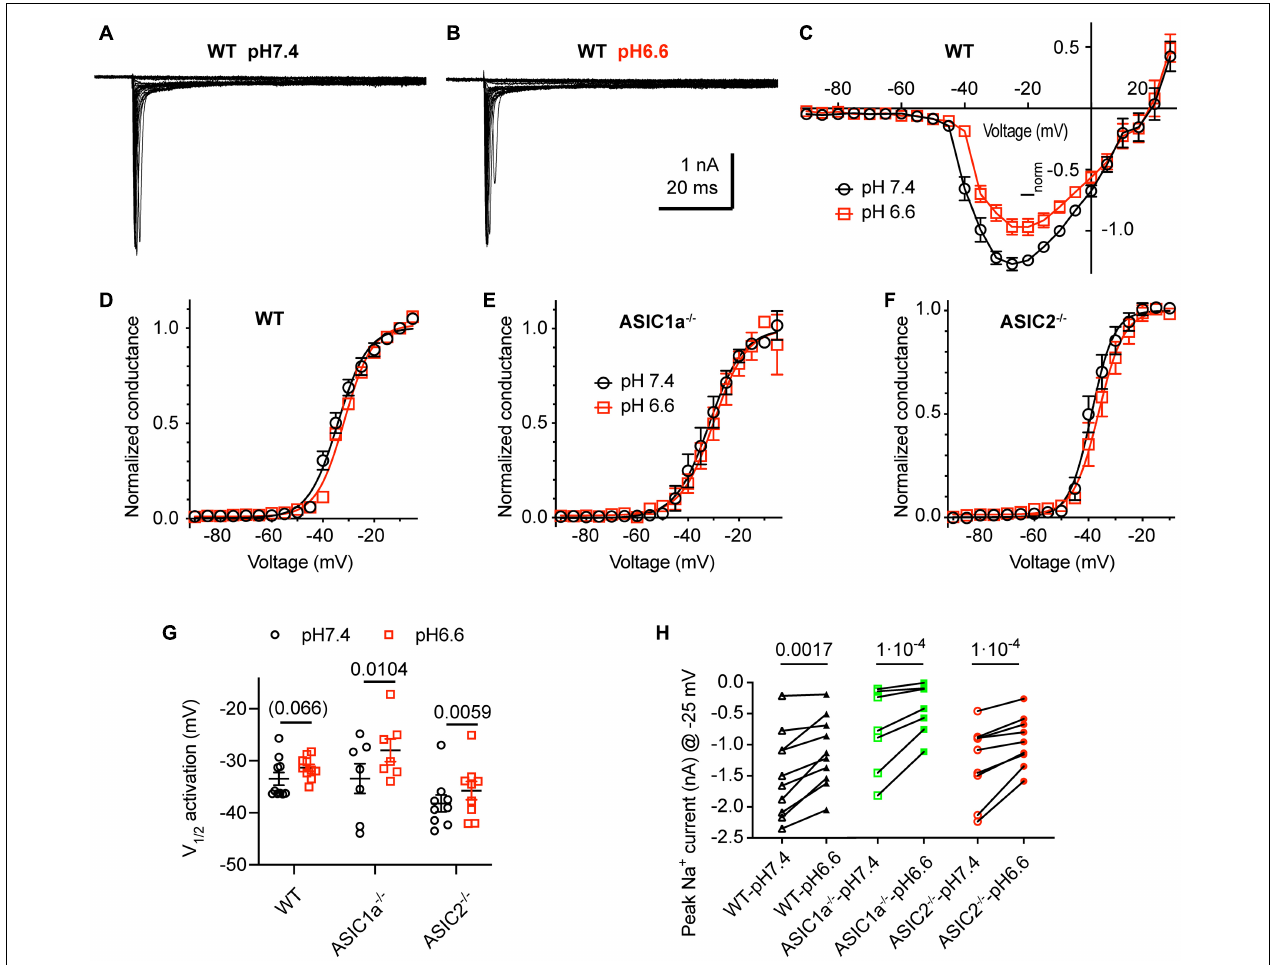
FIGURE 5 | Acidification to pH6.6 induces a small inhibition of voltage-gated Na + channels. Experiments were done in whole-cell voltage-clamp on cortical neurons. The voltage protocols are described under Materials and methods . The response to two different solutions was directly compared in the same cell. Only the pH was changed between the two conditions. (A,B) Representative current traces obtained at pH7.4 (A) and pH6.6 (B) from the same WT neuron (C) Na V I-V curve at pH 7.4 and 6.6. Current amplitudes were normalized in each cell to the amplitude measured at pH7.4 at –10 mV, n = 10. (D–F) Na V conductance-voltage curve at pH 7.4 and 6.6. The conductance was normalized to the conductance at –10 mV. (D) Neurons from WT mice. The V 1 / 2 , determined from a Boltzmann fit, was –33.5 ± 1.2 mV (pH7.4) and –31.3 ± 0.7 mV (pH6.6, p = 0.066, n = 10). (E) Neurons from ASIC1a − / − mice. The V 1 / 2 values were –33.4 ± 2.8 mV (pH7.4) and –28.0 ± 2.2 mV (pH6.6, p = 0.0104, n = 7). (F) Neurons from ASIC2 − / − mice. The V 1 / 2 values were –38.2 ± 1.6 mV (pH7.4), –35.7 ± 1.8 mV (pH6.6, p = 0.0059, n = 9). (G) Plot of the V 1 / 2 values obtained in experiments described in (D–F) . (H) Na V current amplitude at –25 mV, measured from WT, ASIC1a − / − and ASIC2 − / − cortical neurons, n = 7–10. Data of Figure 5 were obtained in an extracellular solution with decreased Na + concentration to improve the clamp control (Materials and methods). P -values derived from paired t -tests are indicated in (G,H)